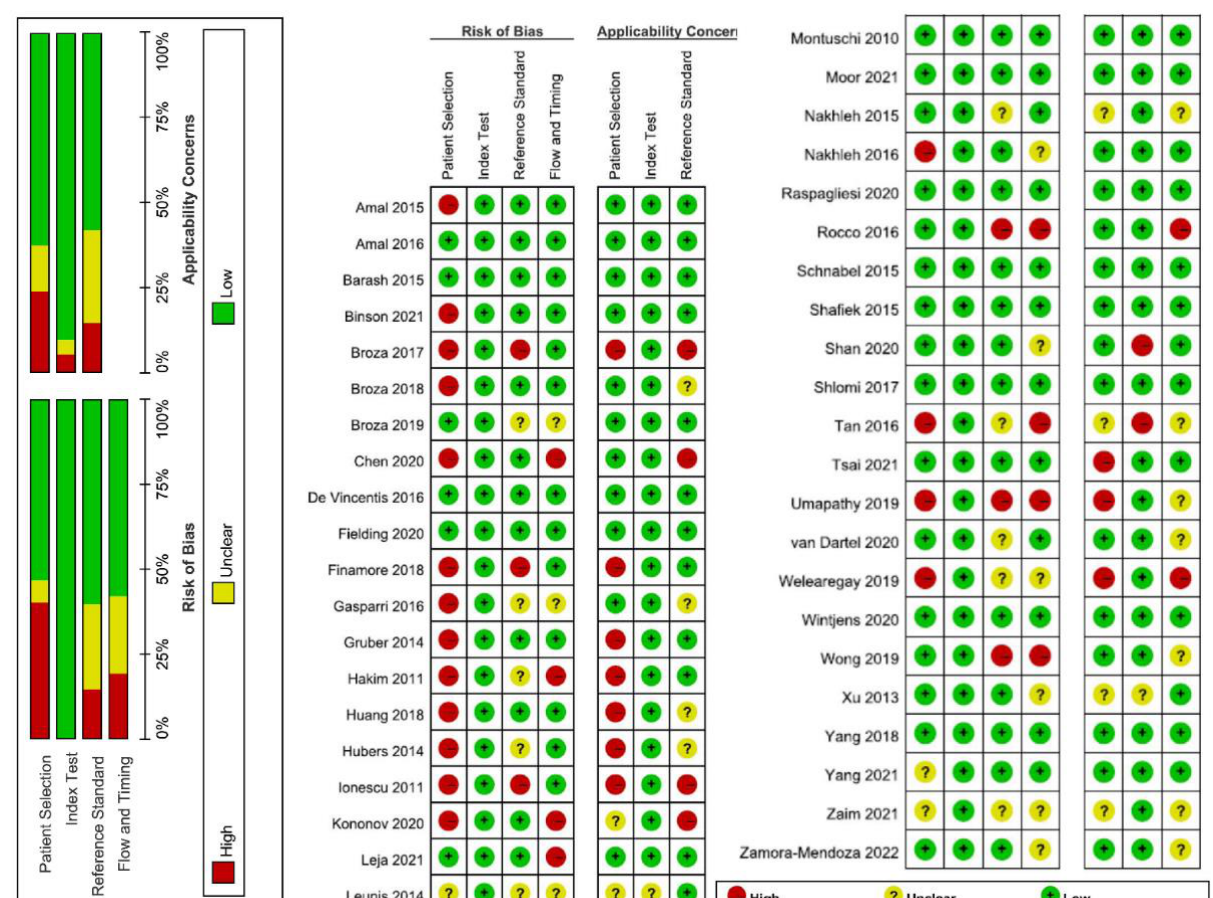
Figure 4. Funnel plot of the diagnostic odds ratio. A skewed asymmetrical funnel plot shows that there is publication bias. In the right lower corner, the small sample size studies (therefore large standard error) are more prone to publication bias than large studies.